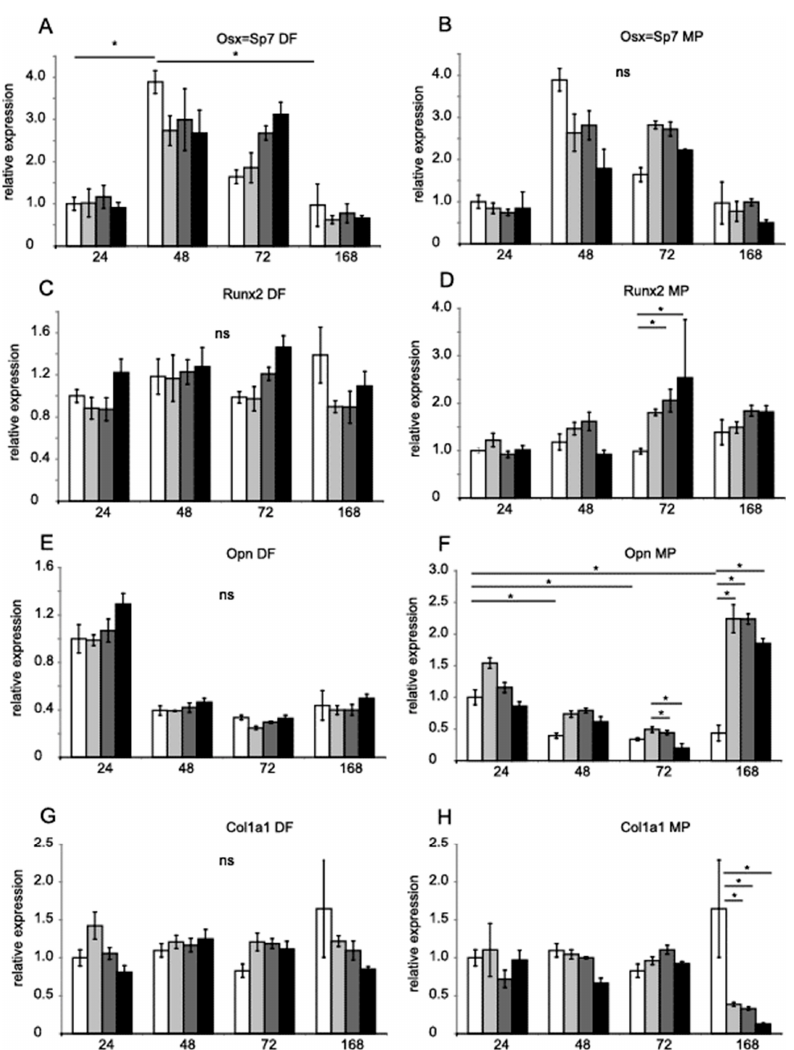
Figure 3. Gene expression in MC3T3-E1 in the presence of DF and MP . Osx , Runx2 , Opn , and Col1a1 mRNA levels in MC3T3-E1 cells treated with DF ( A , C , E , G ) 0.5 µM, 5 µM, 50 µM (increasing grey scale, respectively) for 24 h, 48 h, 72 h, and 168 h. MC3T3-E1 cells were treated with MP ( B , D , F , H ) 0.5, 5, 50 µM (increasing grey scale, respectively) for 24 h, 48 h, 72 h, and 168 h. Untreated control equals 1 (open bars). Results are presented as geometric means of relative expression. Hprt and B2m were used as reference genes. The significance was evaluated using one-way ANOVA with Tukey’s post hoc test. The significance level was set at 5% ( p < 0.05). Error bars represent ± SEM. * p < 0.05.